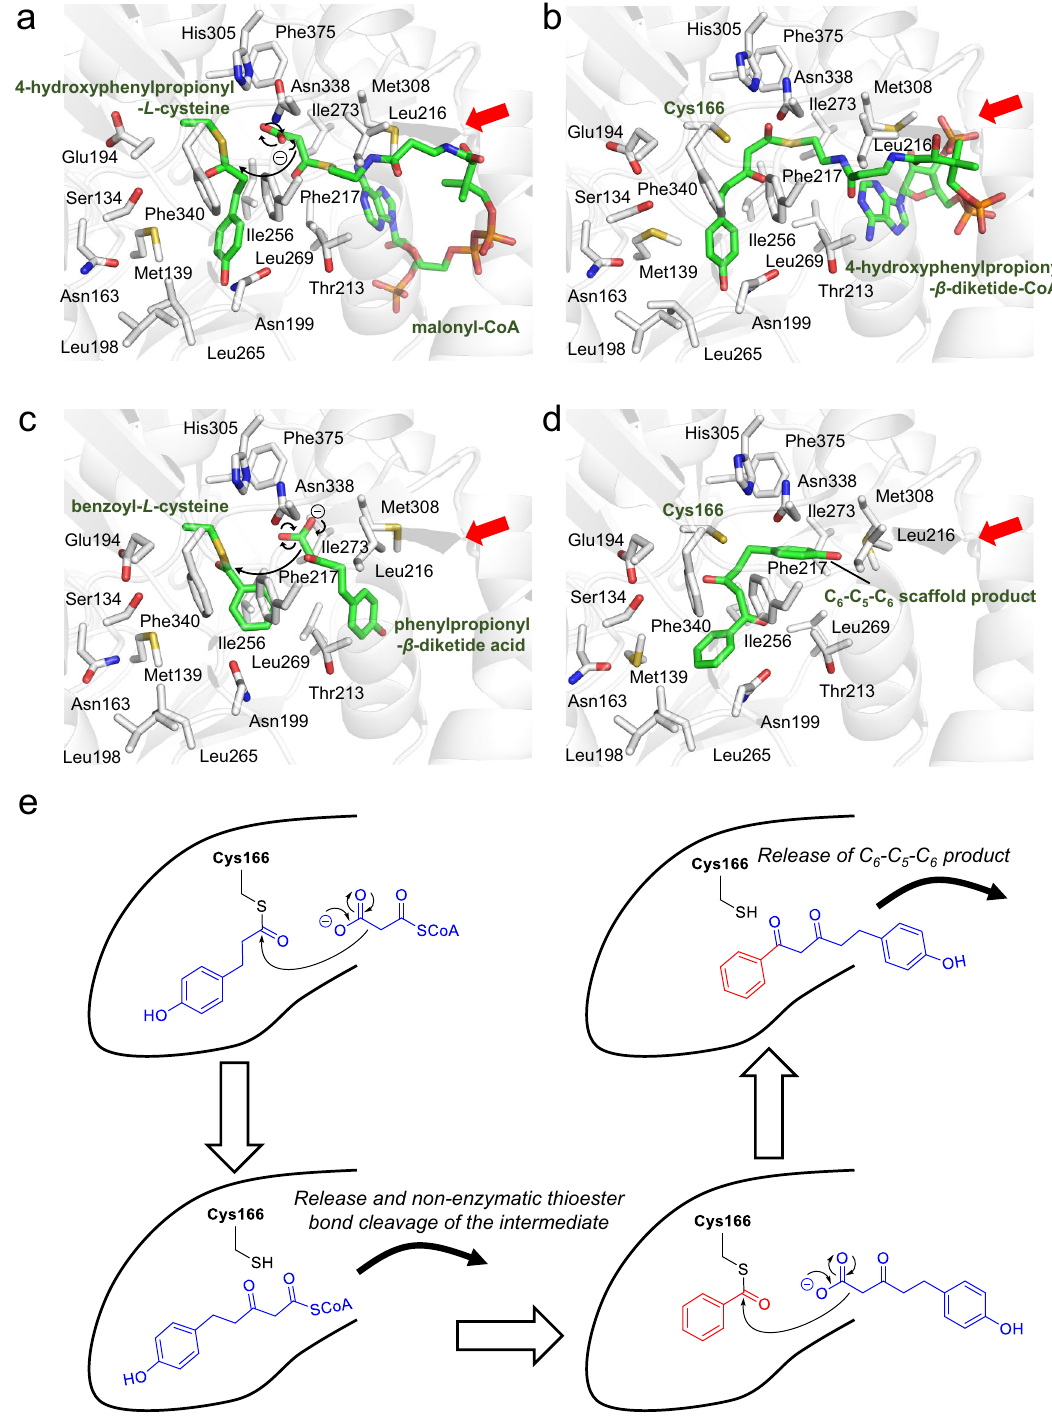
Fig. 5 Proposed mechanism of the formation of the C 6 – C 5 – C 6 scaffold by PECPS. a Decarboxylative condensation of malonyl-CoA with the enzyme- bound 4-hydroxyphenylpropionyl unit. b Formation of the 4-hydroxyphenylpropionyl- β -diketide-CoA intermediate. c Decarboxylative condensation of phenylpropionyl- β -diketide acid nonenzymatically derived from phenylpropionyl- β -diketide-CoA with the enzyme-bound benzoyl unit. d Formation of the C 6 – C 5 – C 6 scaffold product. e Schematic representation of the proposed mechanism of the formation of the C 6 – C 5 – C 6 scaffold by PECPS. The entrances to the catalytic cavities are indicated with red N199F (Fig. 4g) did not indicate critical movement of the Supplementary Fig. 26), suggesting that the relatively reduced architectures around the active site, and further docking calculations activity of the N199L and N199F mutants was due to the for wild type PECPS complexed with 4-hydroxyphenylpropionyl- hydrophobicity or bulkiness caused by the substitutions of Asn199 CoA predicted that the side chain of Asn199 could be essential for to Leu and Phe. These observations suggested that PECPS utilizes ligand binding via hydrogen-bond interactions (Fig. 5 and only the main catalytic pocket to generate the fi nal products.